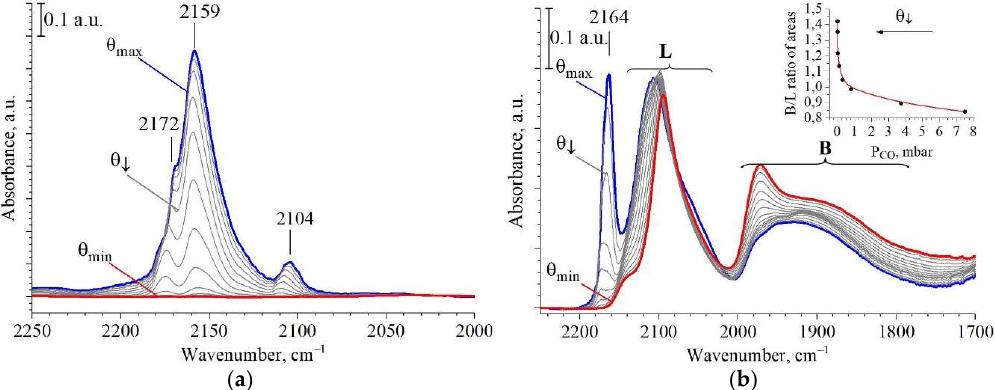
Figure 4. ( a ) CeO 2 and ( b ) Pd/CeO 2 DRIFT spectra during CO desorption at –140 ° C, previously reduced at 200 ° C in a 5% H 2 /Ar mixture. The spectrum measured at the highest CO coverage (θ max , P CO = 4 mbar for CeO 2 and P CO = 7.5 mbar for Pd/CeO 2 ) is highlighted in blue ( — ); the series of spectra obtained during decreasing coverage θ ↓ are shown in grey ( — ); the spectrum after continuous desorption (θ min , P CO = 5×10 –3 mbar) is marked with red ( — ). The dependency of the area ratio under the peaks related to linearly (L) adsorbed CO and bridged (B) carbonyls from the CO pressure is shown on the inset.